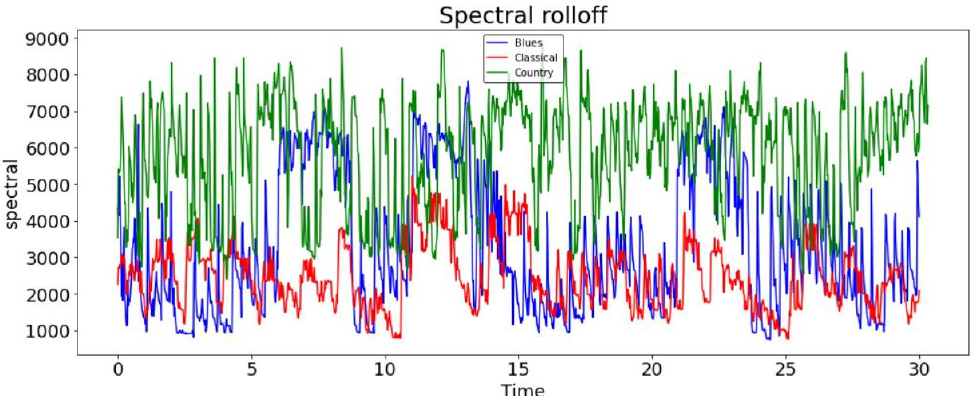
Figure 9. Spectral roll-off (graphical representation) of blues, classical, and country